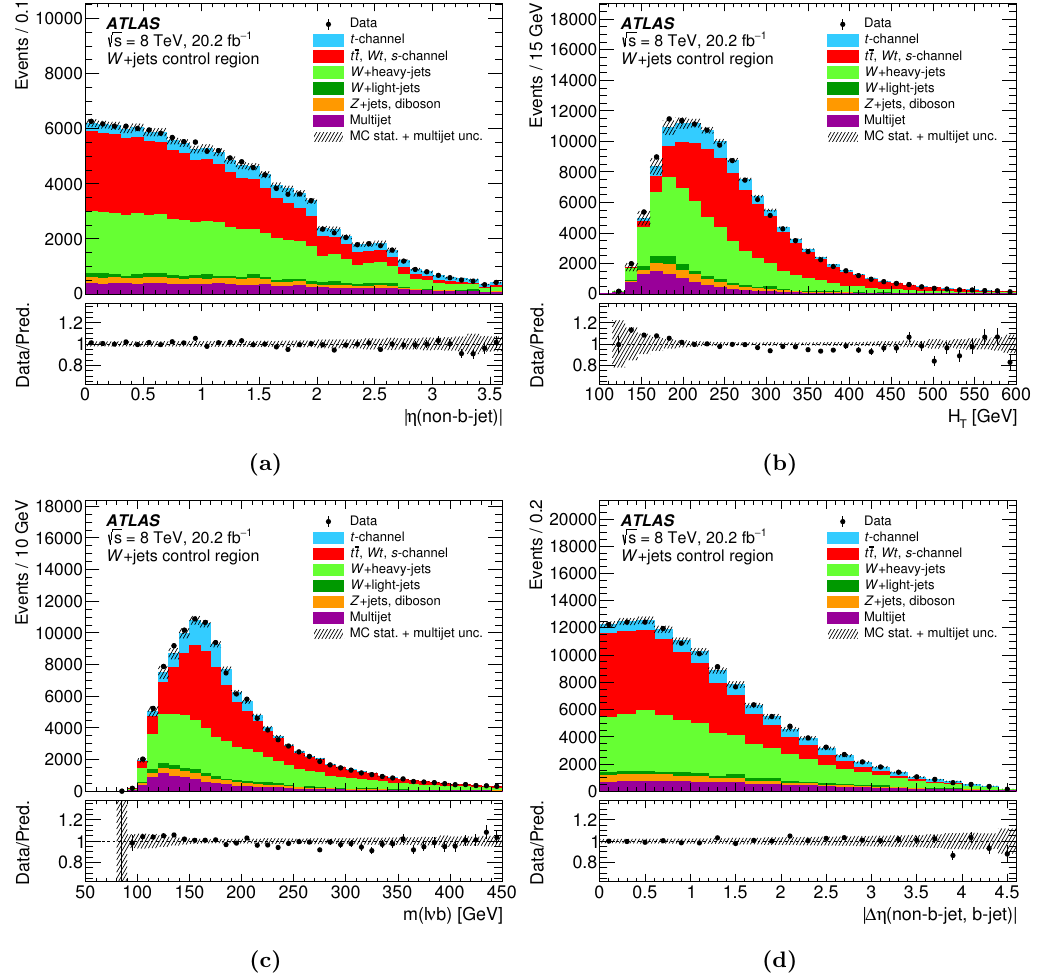
Figure 5. Distributions of (a) (cid:17) (non b -jet) , (b) the scalar sum of the p T of all (cid:12)nal-state objects, j j H T , (c) reconstructed top-quark mass, m ( ‘(cid:23)b ), and (d) (cid:1) (cid:17) (non b -jet ; b -jet) in the W +jets control j j region for the merged electron and muon channels. The multijet background is estimated using data-driven techniques, while contributions from simulated W +jets, top-quark backgrounds and t -channel event samples are normalised to the results of a maximum-likelihood (cid:12)t to event yields in the signal and control regions. The uncertainty bands correspond to the uncertainties due to the size of the simulated event samples added in quadrature with the data-driven normalisation uncertainty of 70% estimated for the multijet contribution. The lower plots show the ratio of data to prediction in each